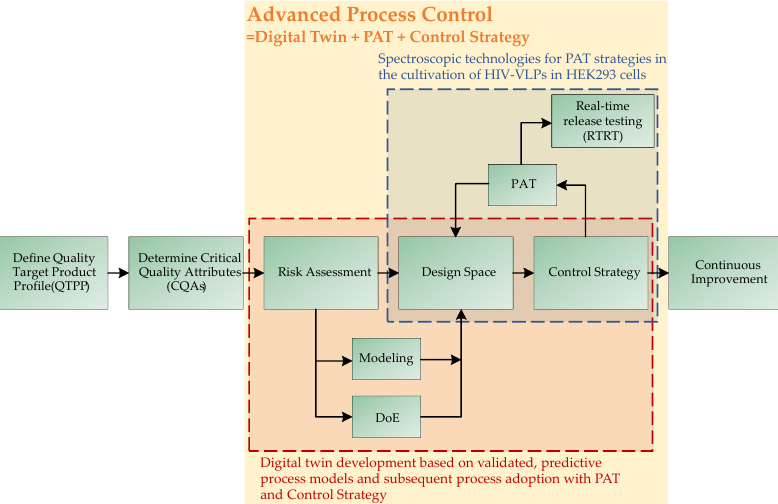
Figure 1. Workflow of model validation based on QbD-based process development. After defining the QTTP and CQAs, a risk assessment of the influence of the defined CQAs should be performed. Based on the risk assessment, a design space can be spanned either by means of a DoE or by modeling approaches. The design space leads to a control strategy, which is assisted by PAT. Furthermore, the implementation of a control strategy allows continuous process optimization [37].